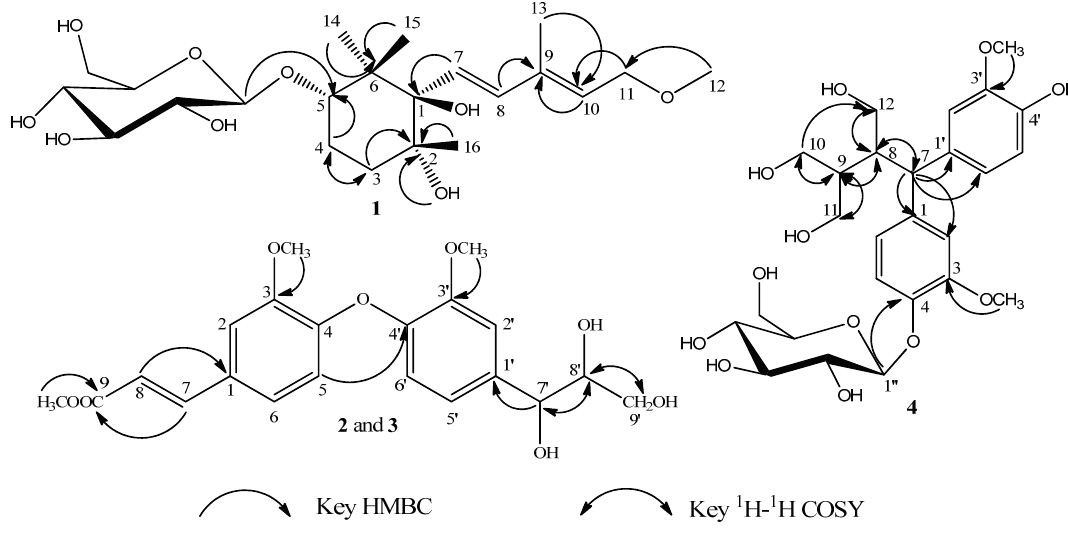
Figure 2. Key HMBC and 1 H- 1 H COSY correlations of 1 – 4 . Table 1. 1 H- and 13 C-NMR data for 1 (500 and 125 MHz, δ